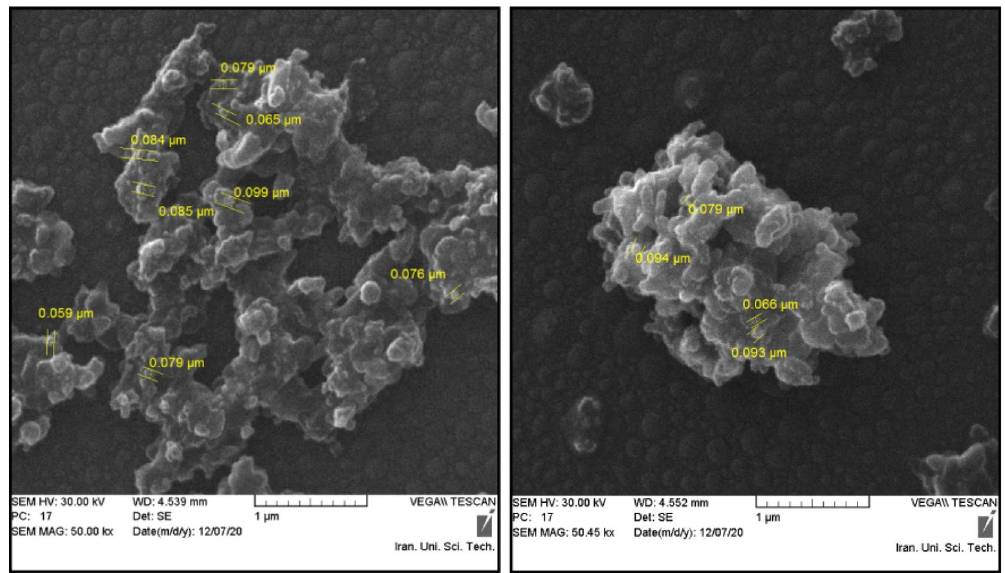
Figure 3. The SEM images of the MCM-41-SO 3 H: the fresh catalyst (left), and the recovered one (right).